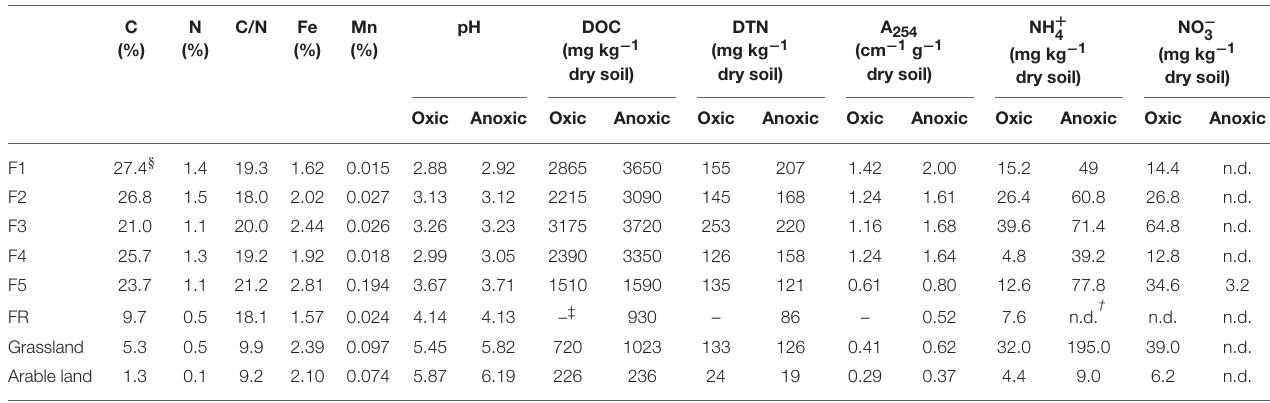
TABLE 1 | Summary of soil properties in this